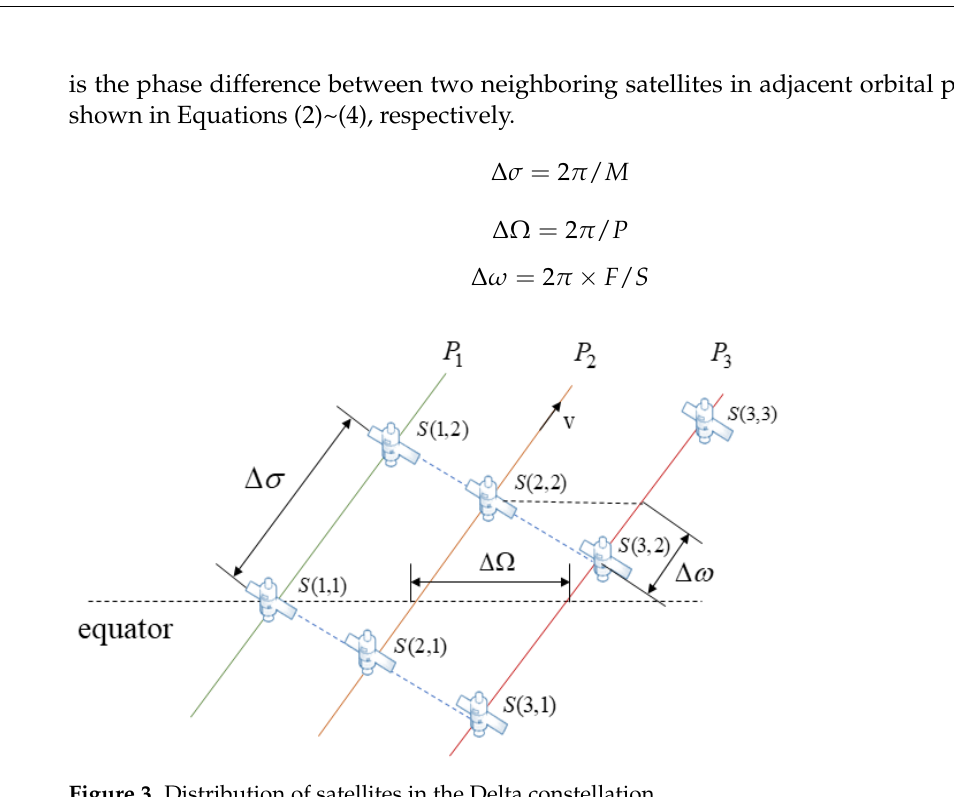
Figure 3. Distribution of satellites in the Delta